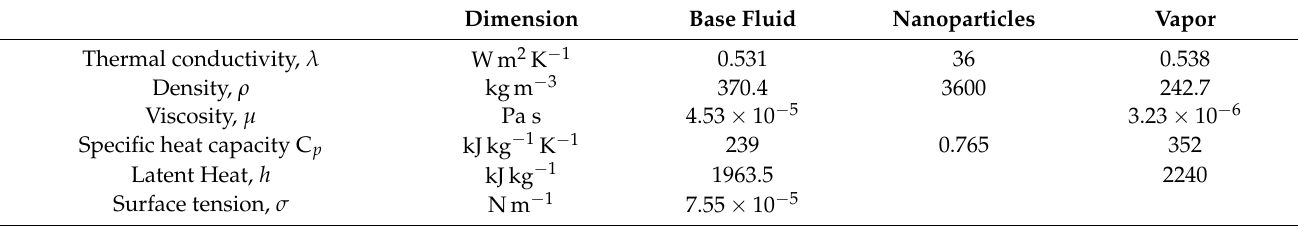
Table 4. Base fluid, nanoparticles, and gas properties used in the laminar film condensation and 2D film boiling benchmark instances. These two benchmark cases are presented and solved in Sections 3.3 and